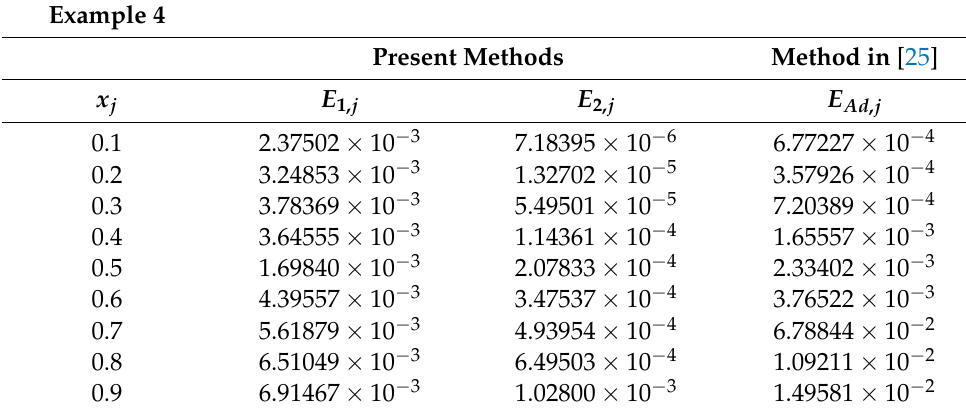
Table 6. Comparison with results given in